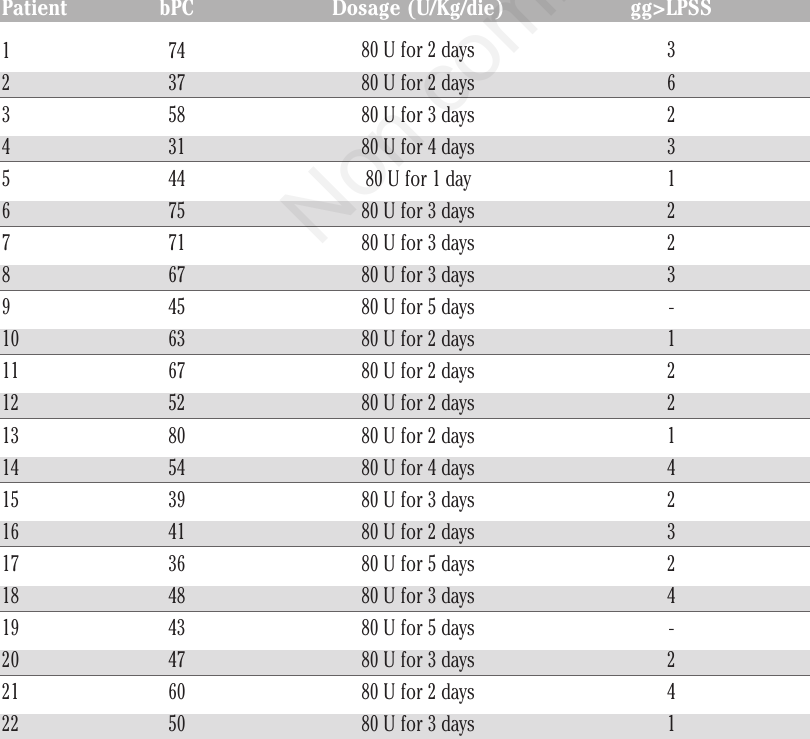
Table 2. Baseline serum protein C levels (bPC), protein C administration dosage and duration and days until a 20% improvement in Lansky performance status scale